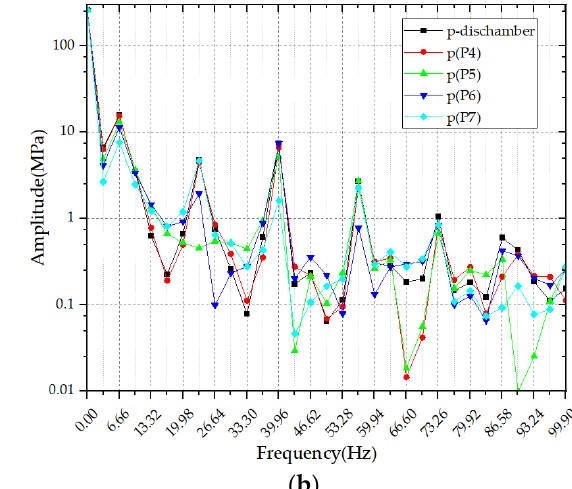
( b ) Figure 11. Amplitude – frequency curves of the pressure. ( a ) Amplitude – frequency curves in the inlet pipeline; ( b ) Amplitude – frequency curves in the outlet pipeline.